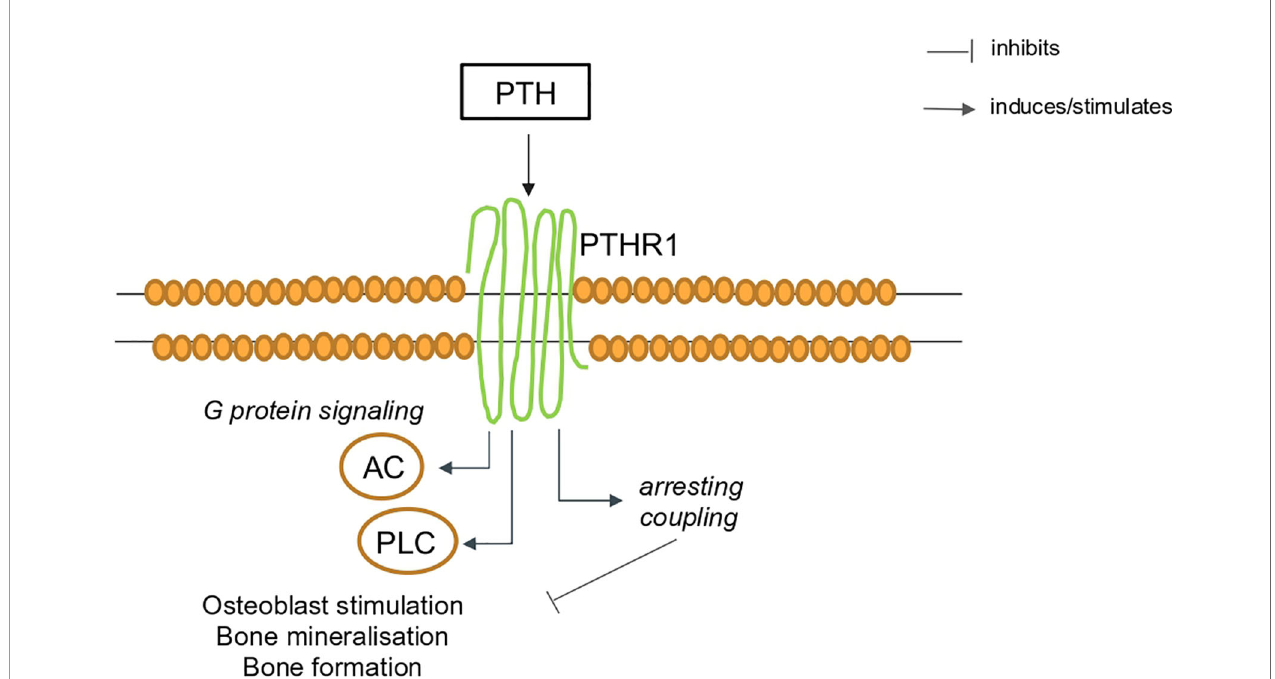
FIGURE 2 | Schematic representation of PTH signaling via the PTH1R in bone. AC, adenylate cyclase; PTH, parathyroid hormone; PTH1R, parathyroid hormone 1 receptor, PLC, phospholipase